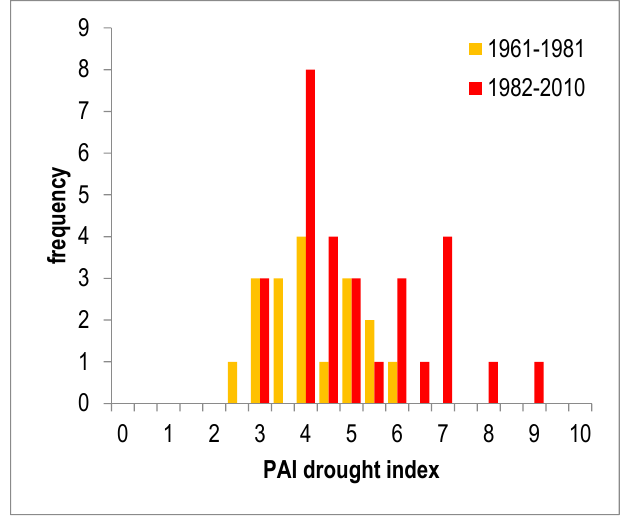
Figure 5. Frequency shift of the annual average values of Pálfai’s drought index (PAI) for two 20-year time periods (1961–1981 and 1982–2010) defined by breakpoint analysis, see also [32].